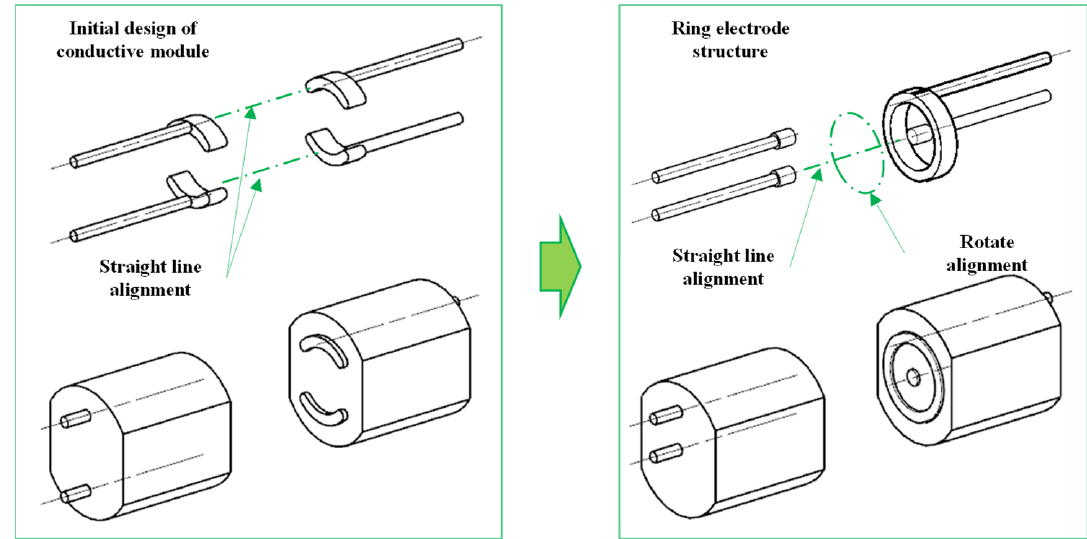
Figure 11. Improved conductive module structure.